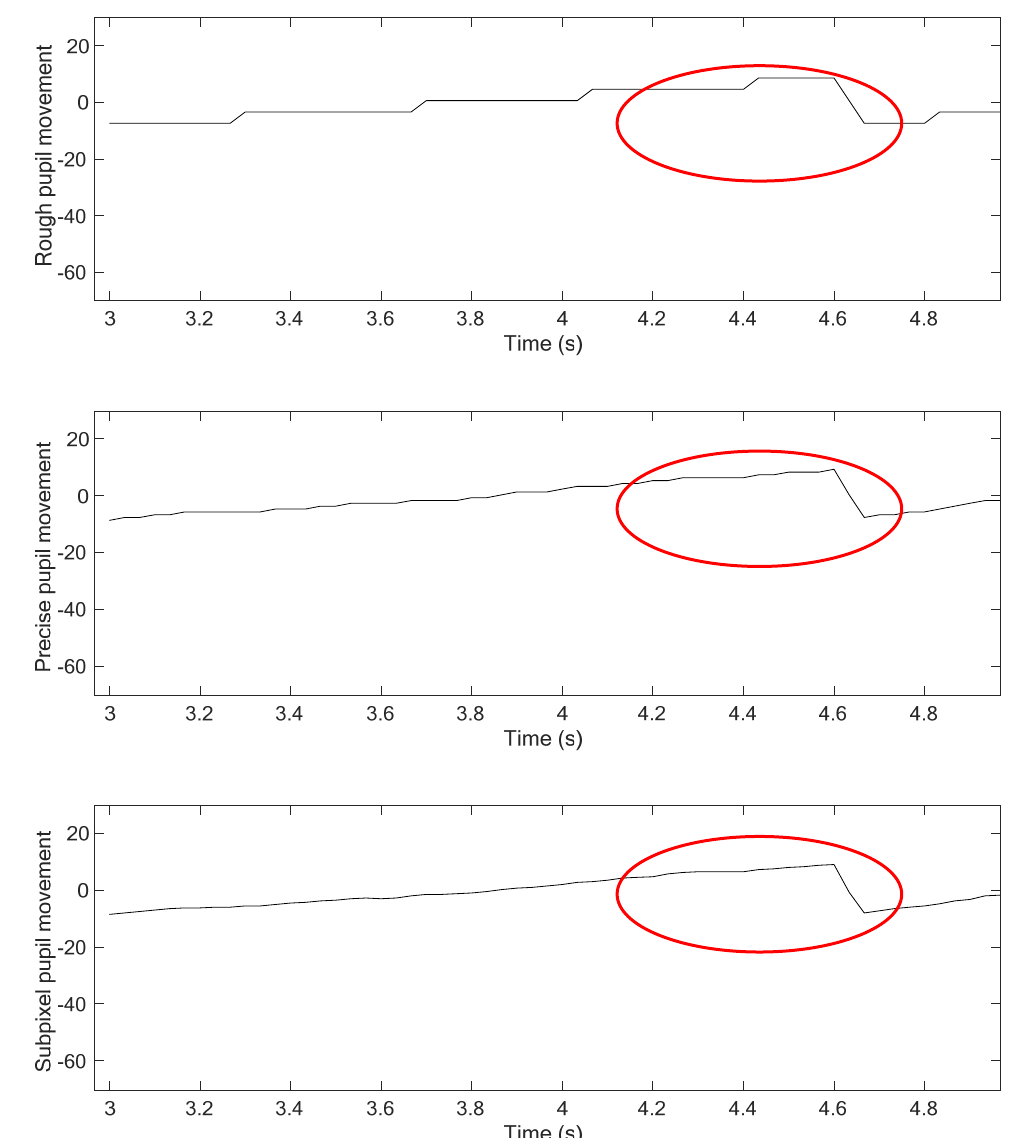
Figure 7. Comparison of rough, precise, and subpixel detection results.